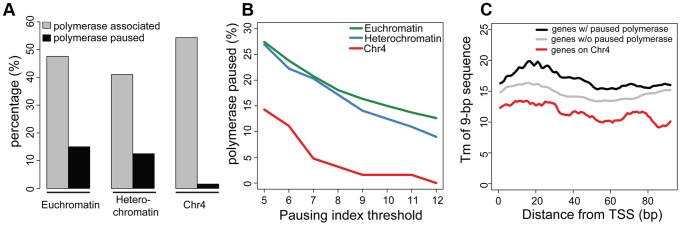
Chromosome 4 has a very low incidence of polymerase pausing identified by GRO-seq data.A. The bar graph shows the percentage of transcripts associated with RNA polymerase (grey) and the percentage of those RNA polymerase-associated genes exhibiting significant pausing (black) for euchromatin, pericentric heterochromatin, and chromosome 4. A pausing index (PI) threshold value of 10 was used. B. The low frequency of polymerase pausing observed for chromosome 4 is independent of the PI selected. C. The average Tm of 9-mers downstream of the TSS for chromosome 4 genes tends to be lower than that of other genes. Tm (Y-axis) of 9-mers in the 100 bp downstream of the TSS (bp, X-axis) is compared for genes on chromosome 4 (red) to genes classified as either paused (black) or not-paused (grey) by GRO-seq analysis. Data from S2 cells [23].